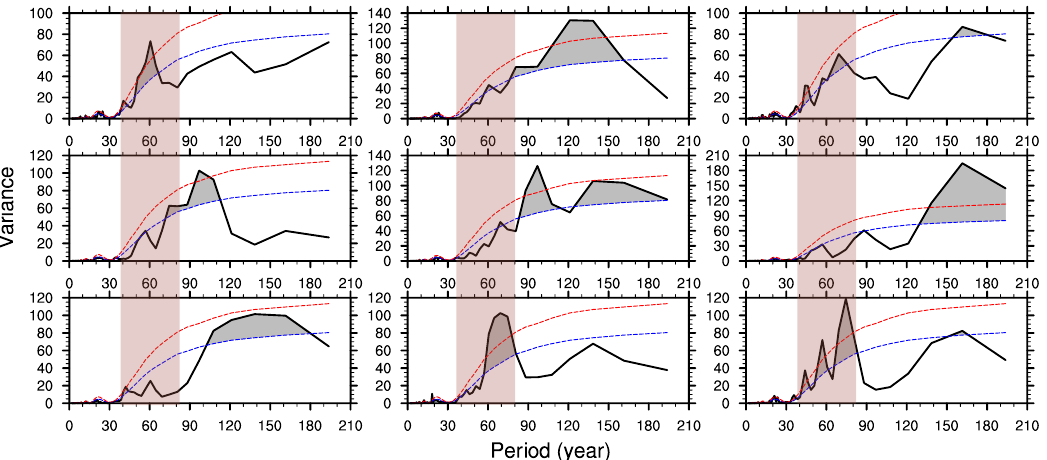
Figure 9. Same as Fig. 7 but for 31-year RCs in nine CESM-LME full-forcing experiments.